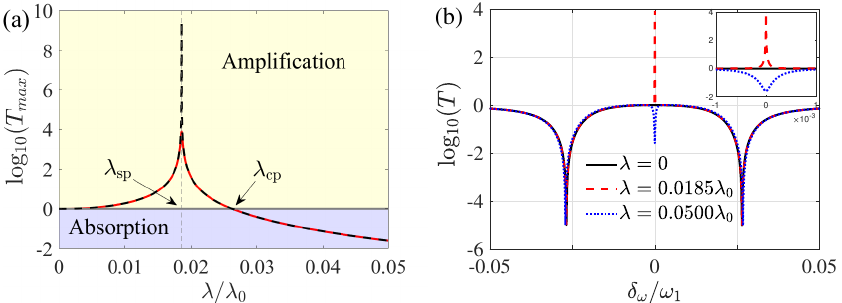
Figure 8. ( a ) The transmission rate T max at resonance as a function of the Coulomb coupling strength λ for N = 0 (black dashed line) and N (cid:54) = 0 (red solid line). ( b ) The transmission rate T as a function of the normalized frequency δ ω / ω 1 for different Coulomb coupling strengths, in which γ 2 = − γ 1 , κ = 0.1 κ 0 , η = 1/2, and P = 2 mW. The other parameters are the same as given in Figure 2.